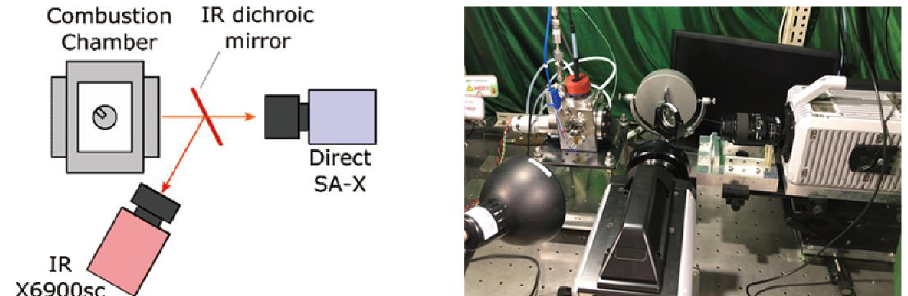
Figure 2. Infrared high-speed camera (FLIR X6900sc). Figure 3. Schematics of the imaging method.